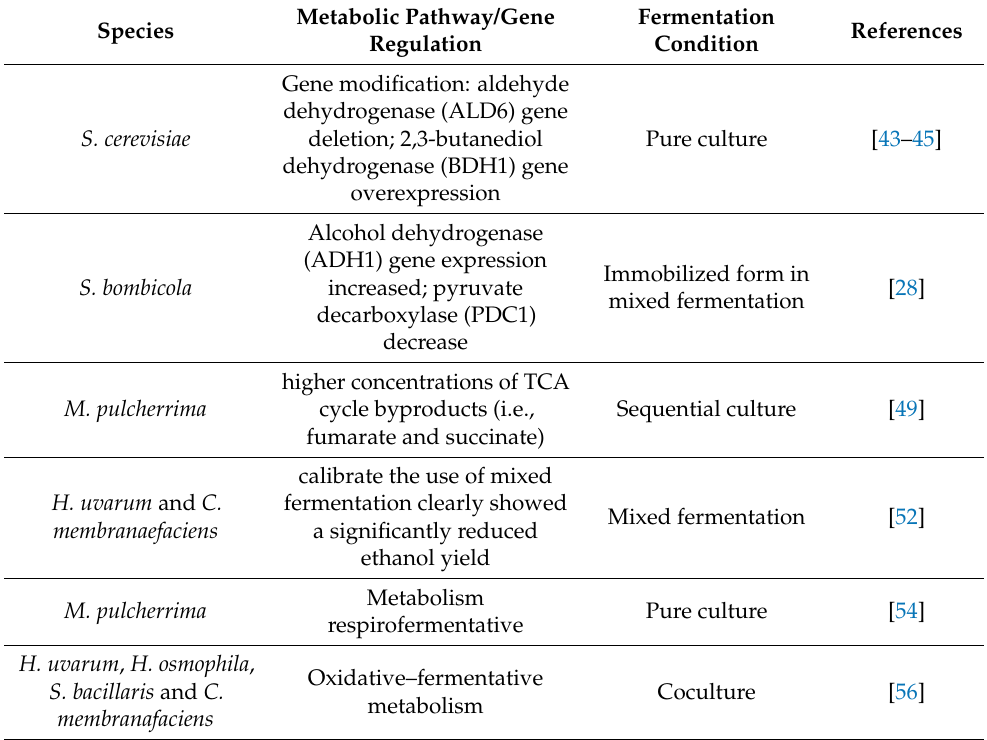
Table 2. Metabolic regulation in ethanol reduction in different wine